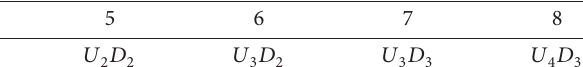
S of the different